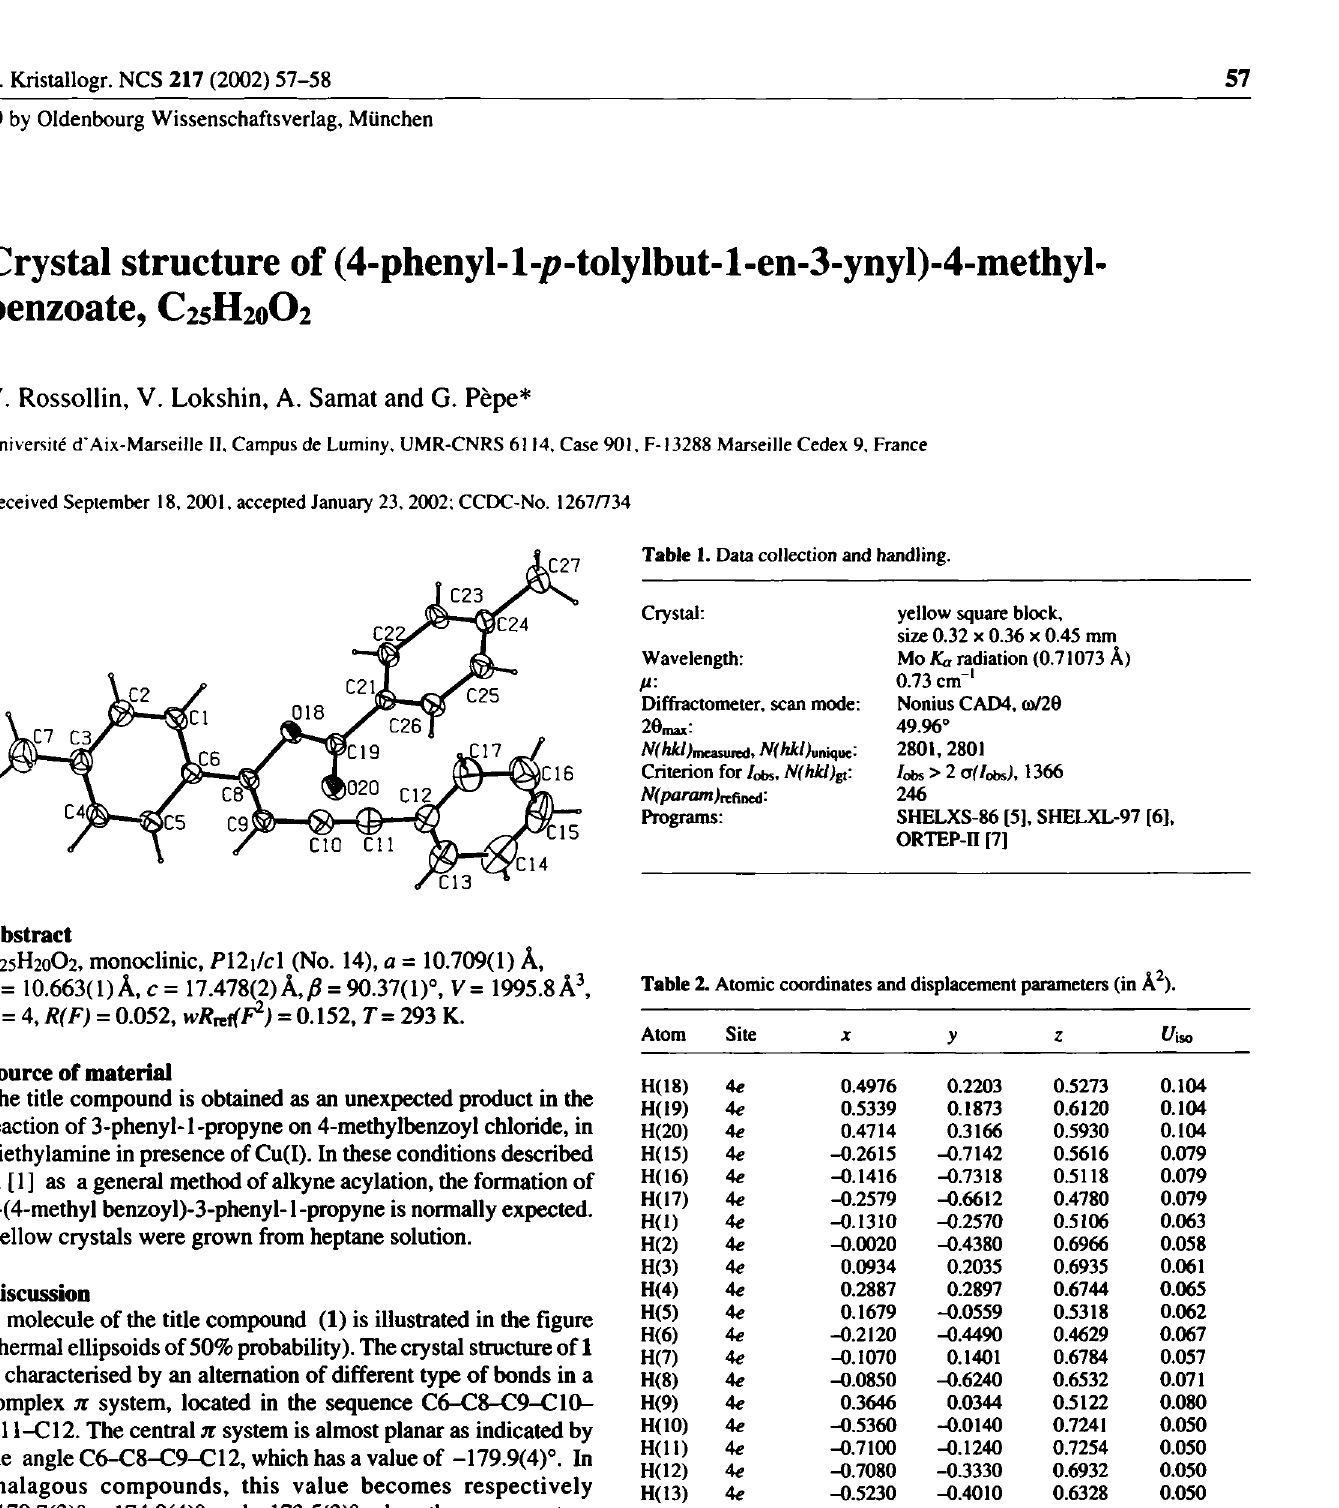
Table 2. Atomic coordinates and displacement parameters (in λ 2